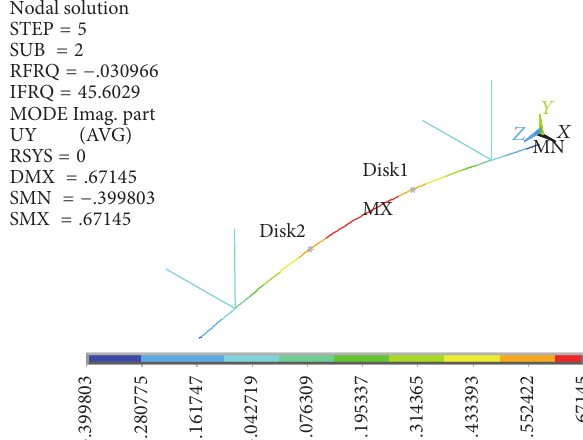
Figure 4: The first-order mode shape of the rotor